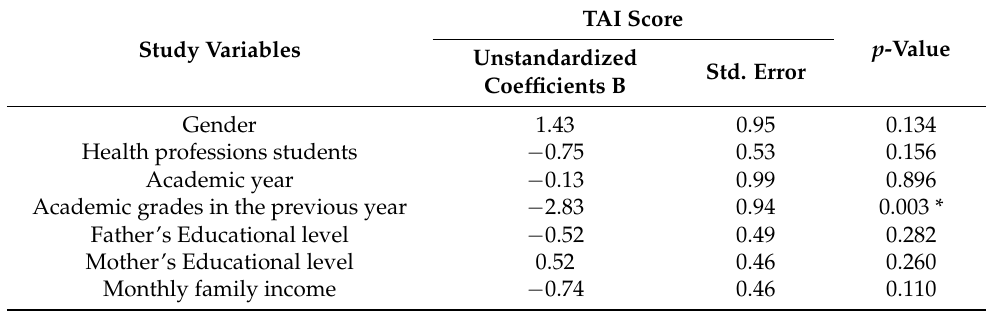
Table 3. Multivariateanalysis: Relationshipbetweentestanxietyanddemographicfactorsamongstudents.